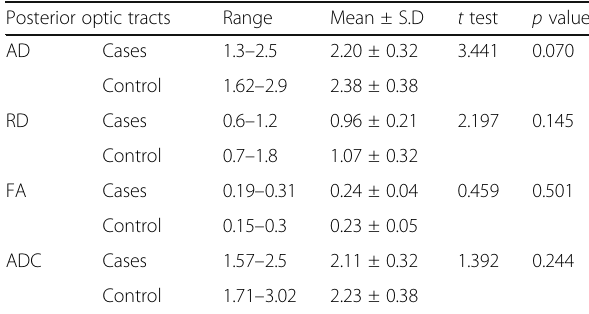
Table 7 A comparison between the DTI parameters (AD, RD, FA, ADC) of posterior optic